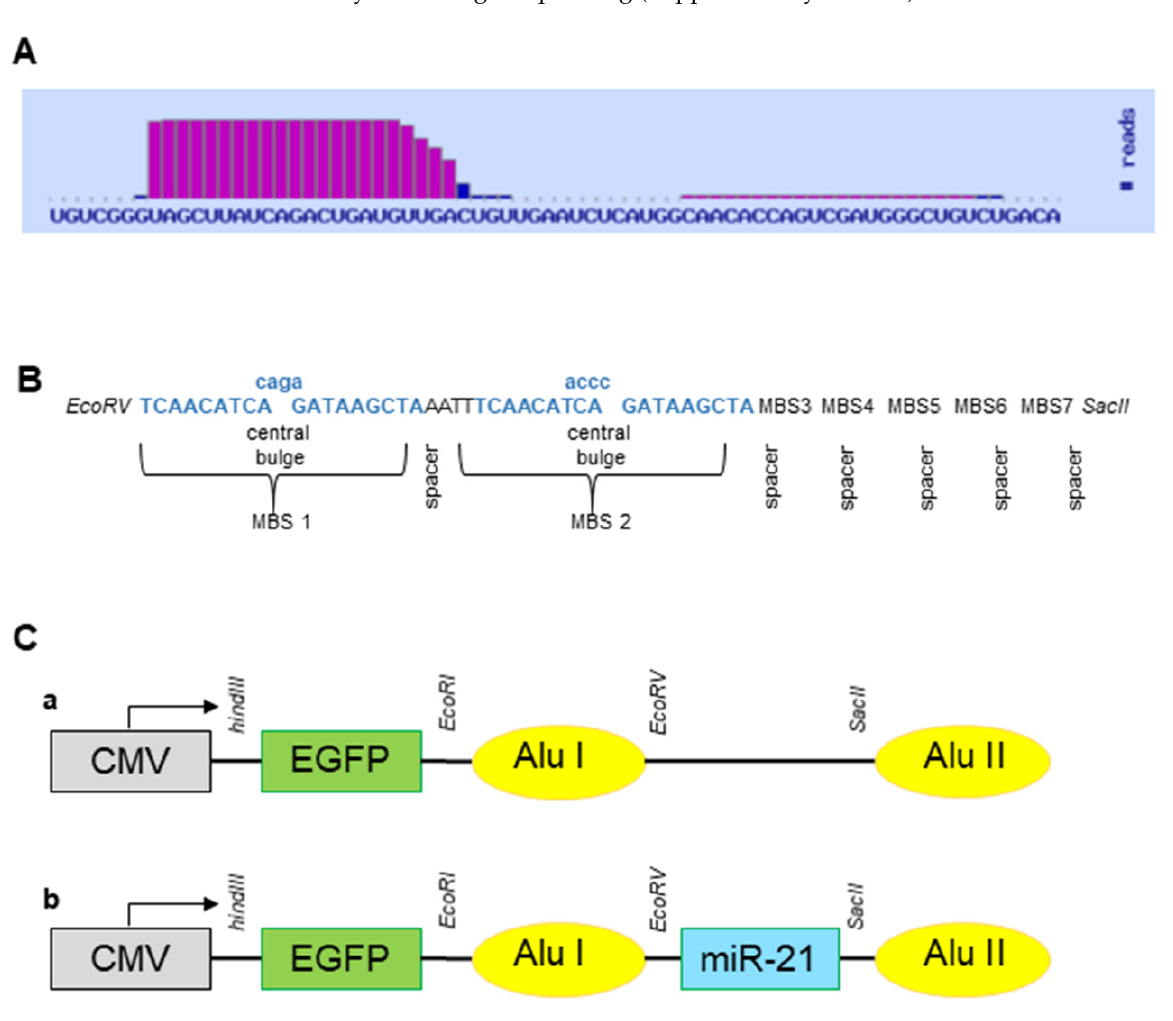
Figure 2. miR-21 sponge expression system. ( A ) hsa-miR-21-5p sequence from miRNABase database. ( B ) Design of the miR-21 sponge. ( C ) Sequence of subcloned into pcDNA3.1 (+) CircRNA Mini Vector: ( a ) Subcloned EGFP gene upstream of Alu sequence (Circ-EGFP); ( b ) miR-21 was in Circ-EGFP between Alu sequences (Circ-21).